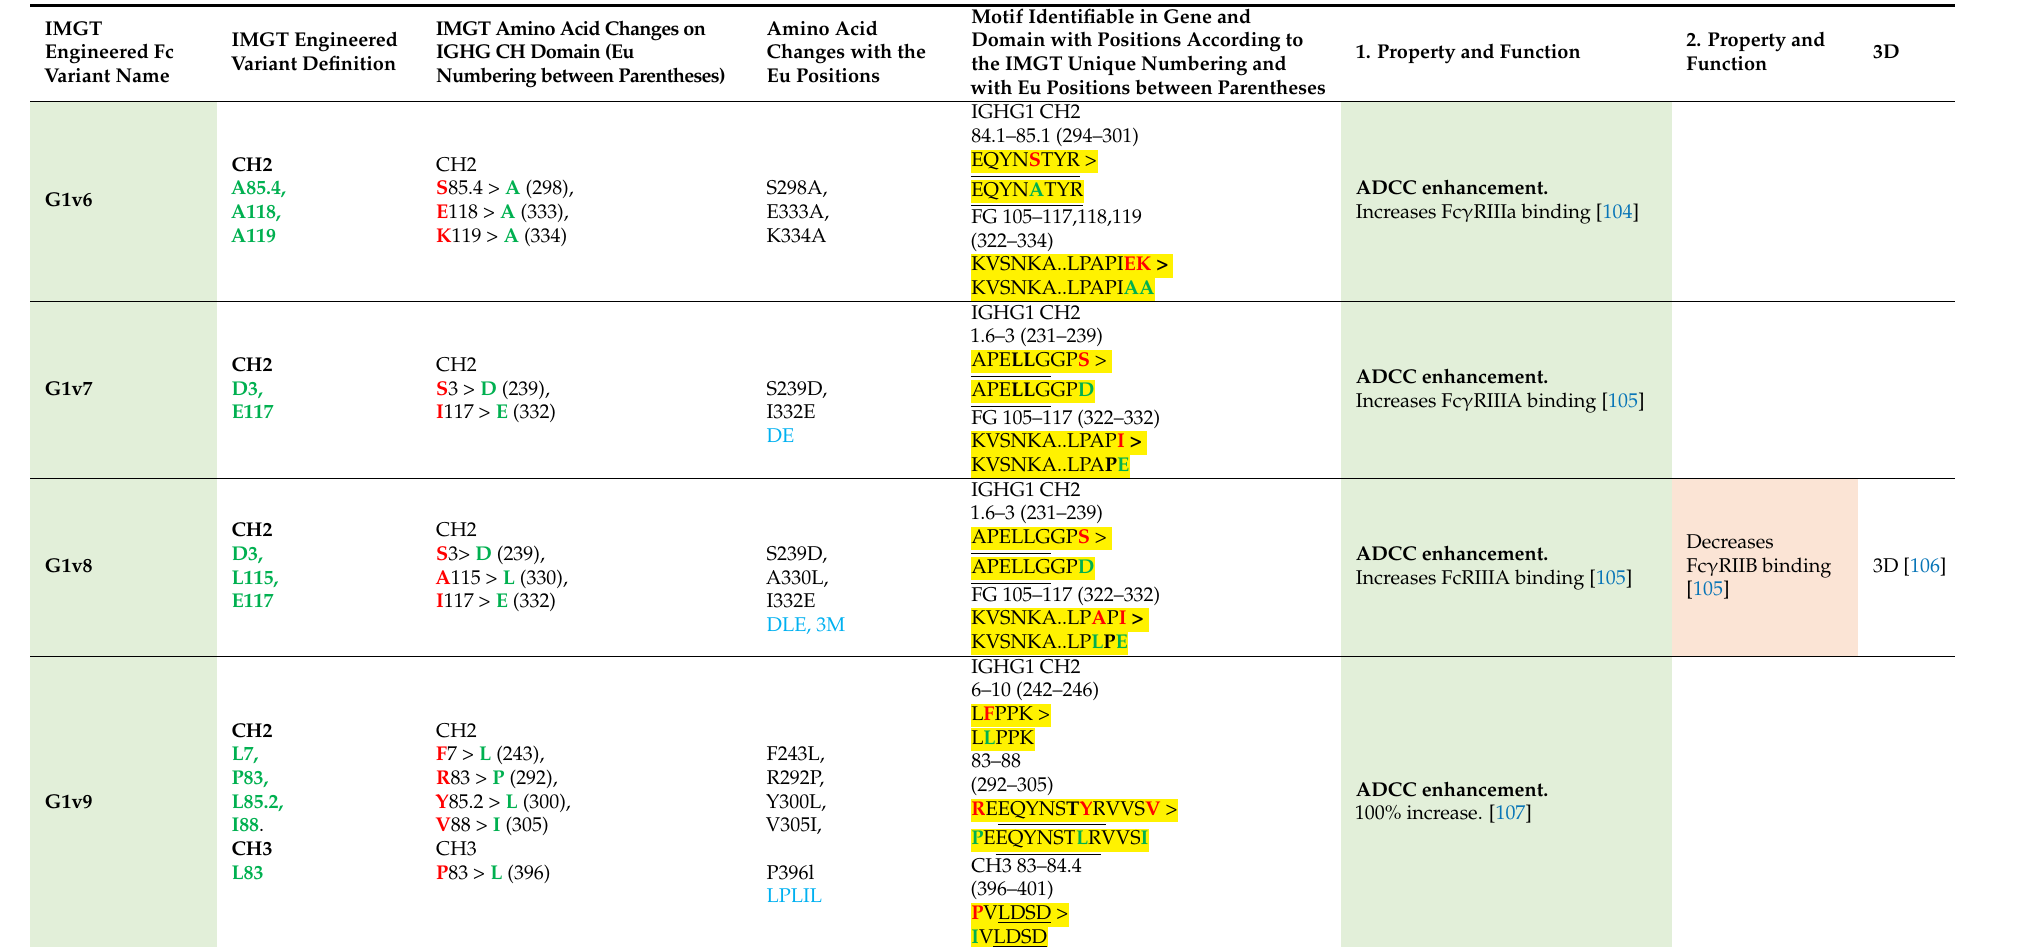
Table 6. IMGT nomenclature, Eu positions and IMGT motif of engineered Fc variants involved in antibody-dependent cellular cytotoxicity (ADCC) enhancement (Effector